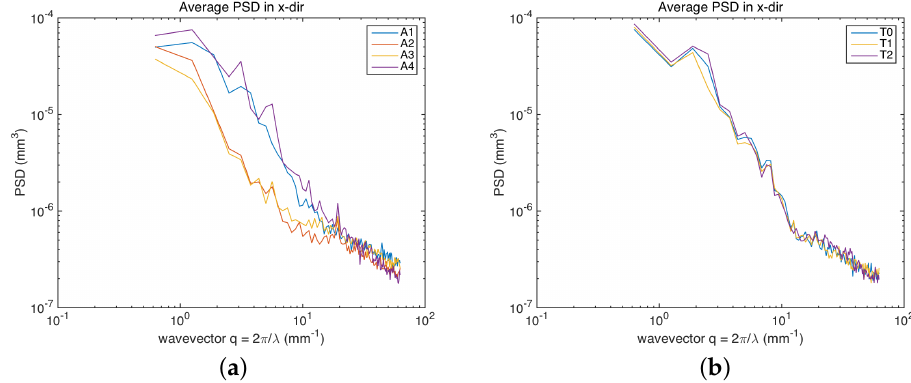
Figure 8. Average PSD along the scan direction: ( a ) multiple ROIs of red lake. ( b ) Single ROI of